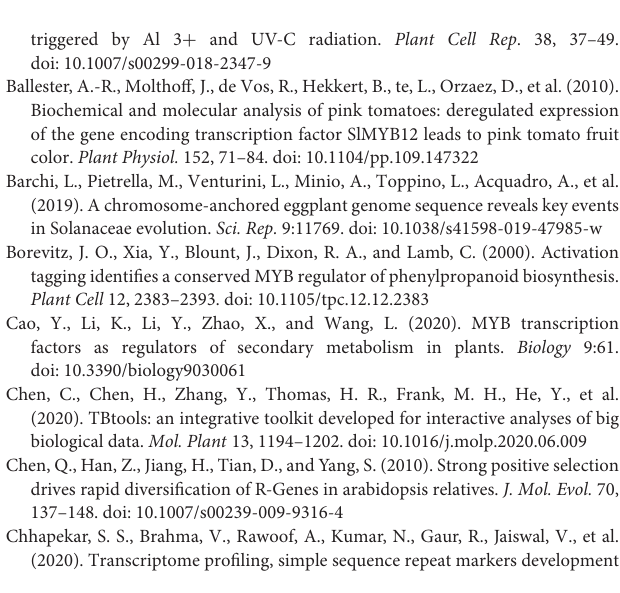
Supplementary Figure 1 | Chromosomal distribution of MYB genes across 12 Capsicum chromosomes of (A) C. annuum and (B) C. baccatum. The capsaicinoid QTLs in C. annuum adapted from Han et al., 2018 are shown in shaded blocks. Supplementary Figure 2 | Gene structure and phylogenetic tree of MYB genes in (A) C. annuum and (B) C. baccatum . The length of MYB genes are in a kb (kilobase) scale, and the exons are represented using purple and brown blocks, while the connecting lines represent the intronic regions. Supplementary Figure 3 | Phylogenetic tree of MYB protein sequences from the three Capsicum species ( C. chinense , C. annuum, and C. baccatum ). The tree was constructed using the Maximum Likelihood method with 1,000 bootstrap replications. Supplementary Figure 4 | Predicted 3D structural models of 126 C. chinense R2R3 MYB proteins. Models were shown in rainbow color from N to the C terminus. Supplementary Figure 5 | The phylogenetic tree is drawn from MYB protein sequences of C. chinense , C. annuum , C. baccatum , tomato, potato, and Arabidopsis using the Maximum likelihood method with 1,000 bootstrap values.